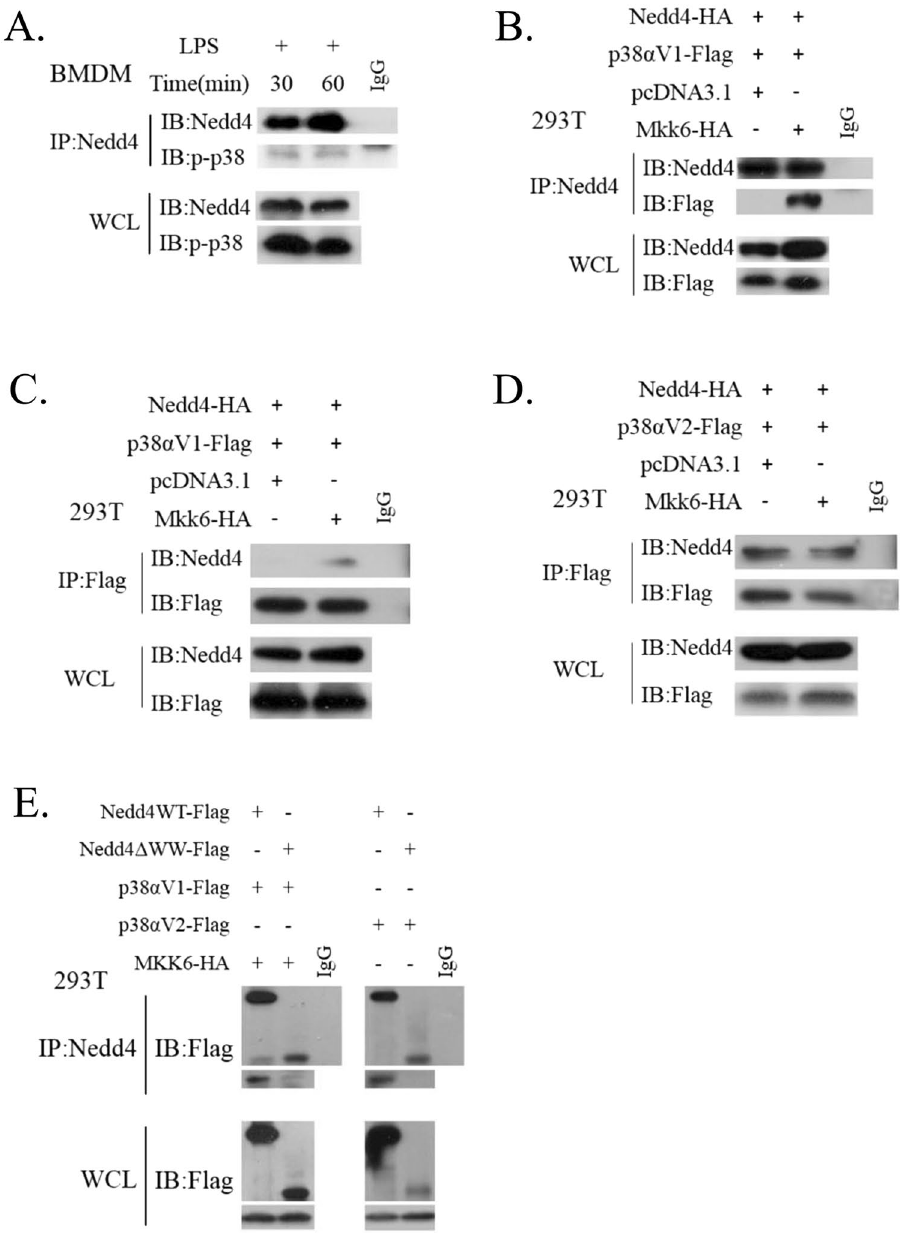
Figure 4. Nedd4 can interact with endogenous and exogenous p38 α . ( A ) Nedd4 interacts with endogenous p-p38 α . iBMDMs cells were incubated with LPS at the indicated times (30 min and 60 min), lysed, immunoprecipitated with anti-Nedd4, gel separated and detected with anti-p-p38 antibody. ( B , C ) The interaction between Nedd4 and p38 α V1 requires phosphorylation of p38 α V1 by MKK6. HEK293 cells co- transfected with various molecules (above lanes), lysed, immunoprecipitated with anti-Nedd4, gel separated and detected with anti-Flag antibody ( B ); immunoprecipitated with anti-Flag, gel separated and detected with anti-Nedd4 antibody ( C ). ( D ) The interaction between Nedd4 and p38 α V2 does not require phosphorylation of p38 α V2 by MKK6. 293T cells co-transfected with various molecules (above lanes), lysed, immunoprecipitated with anti-Flag, gel separated and detected with anti-Nedd4 antibody. ( E ) Nedd4 interacts with p-p38 α V1 and p38 α V2 by its WW domains. These results are represented from three independent